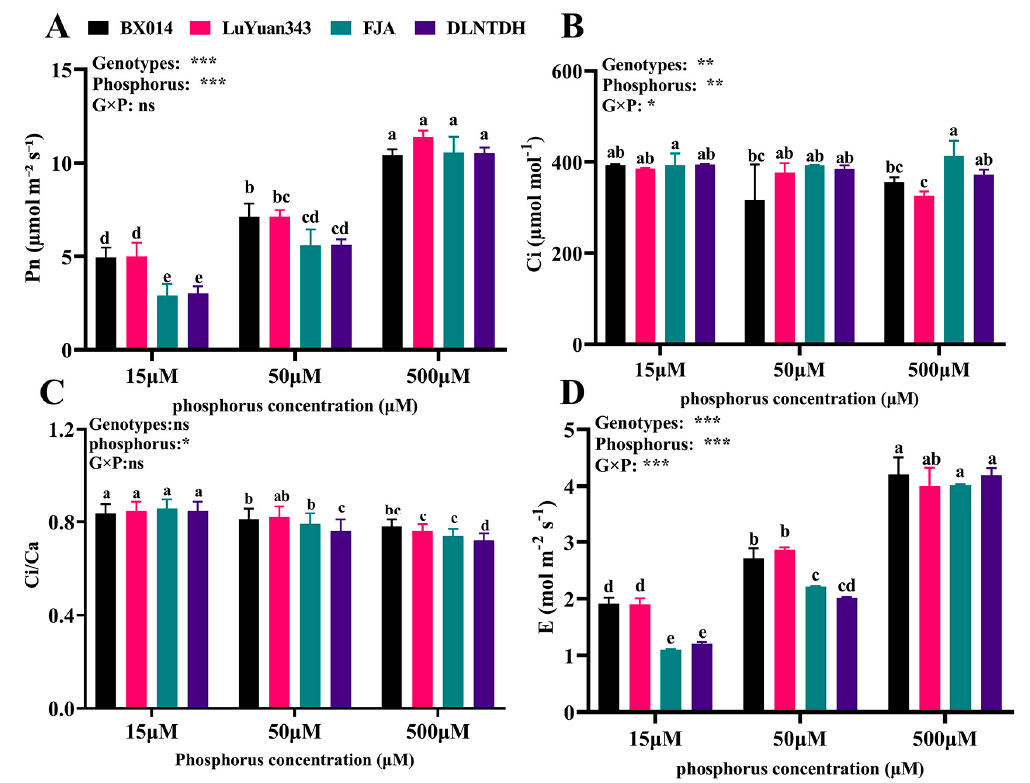
Figure 1. Effects of different P treatments on gas-exchange parameters. ( A ) Pn (net photosynthesis rate), ( B ) Ci (intercellular CO 2 concentration), ( C ) Ci/Ca (ratio of intercellular-ambient-CO 2 concentrations), and ( D ) E (transpiration-rate) content in the cotton genotypes, fully expanded barley leaves. The results are expressed as means ± SE ( n = 7). Statistically significant changes are indicated by different letters, using the two-way ANOVA and multiple-comparison test ( p ≤ 0.05). p -values of the ANOVAs of genotypes (G), phosphorus level (P), and their interaction (G×P) are indicated as ns, not significant; *: p < 0.05, **: p < 0.01, ***: p < 0.001.